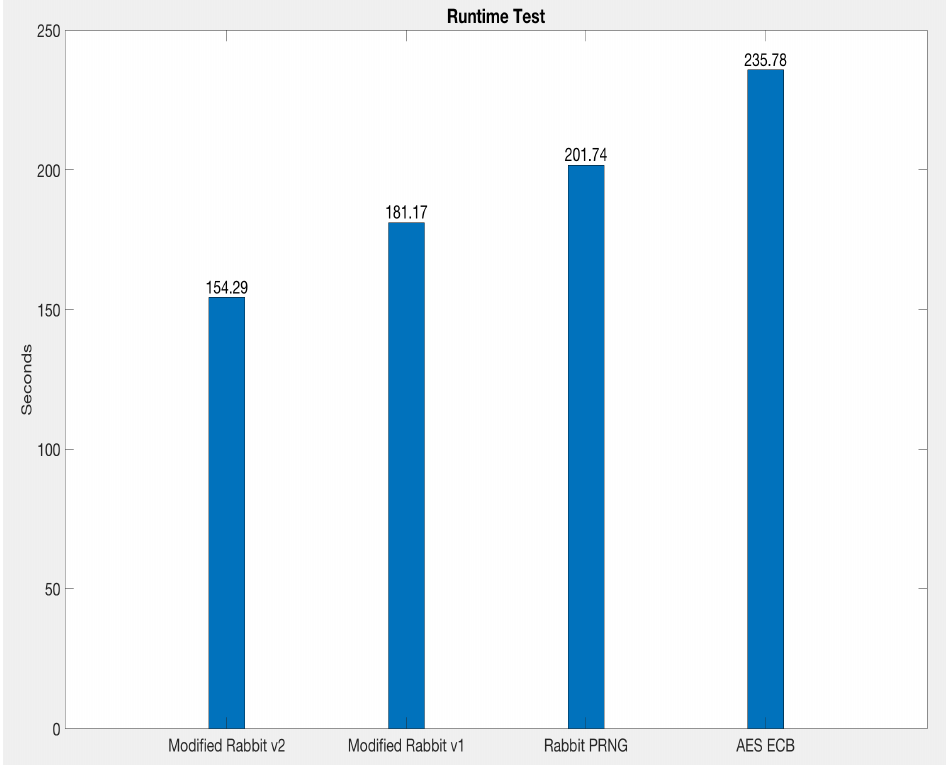
Figure 6. Runtime Test: Modified Rabbit v2 vs Modified Rabbit v1 vs Rabbit vs AES